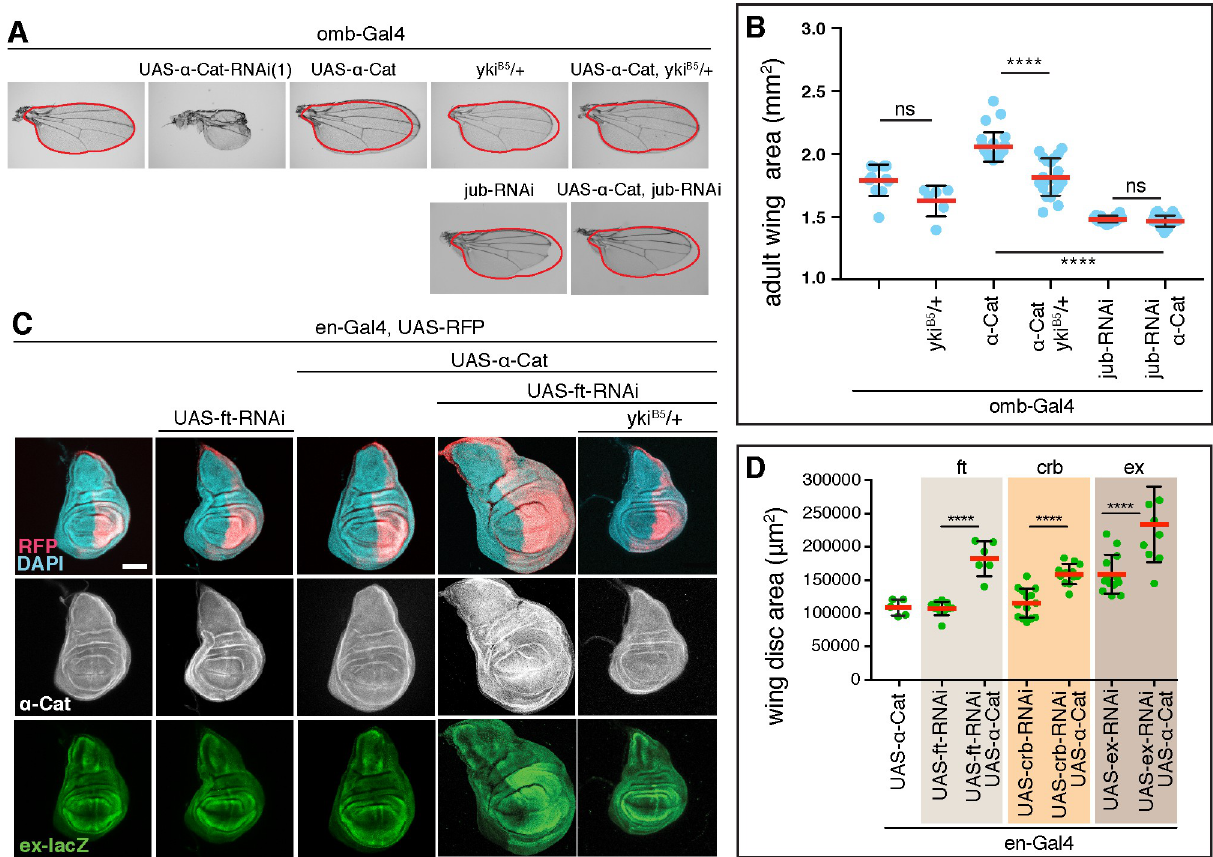
Fig 5. α -Cat overexpression activates Yki. (A, B) Overexpression of α -Cat causes an enlargement of the adult wing, which can be suppressed by one mutant copy of yki B5 or jub-RNAi . Two-tailed, unpaired t-test was used to determine statistical significance. ns(P > 0.05), ���� (P � 0.0001). (C, D) Overexpression of α -Cat does not cause a significant enlargement of the late 3 rd larval instar wing disc. However, overexpression of α -Cat in conjunction with a KD of an upstream regulator of the Hippo/Yki pathway (Fat, shown in (C), Crb and Ex shown in S3 Fig; all three interactions quantified in (D)) showed synergistic overgrowth phenotypes. Scale bars, 100 μ m. Two-tailed, unpaired t-test; ���� (P �